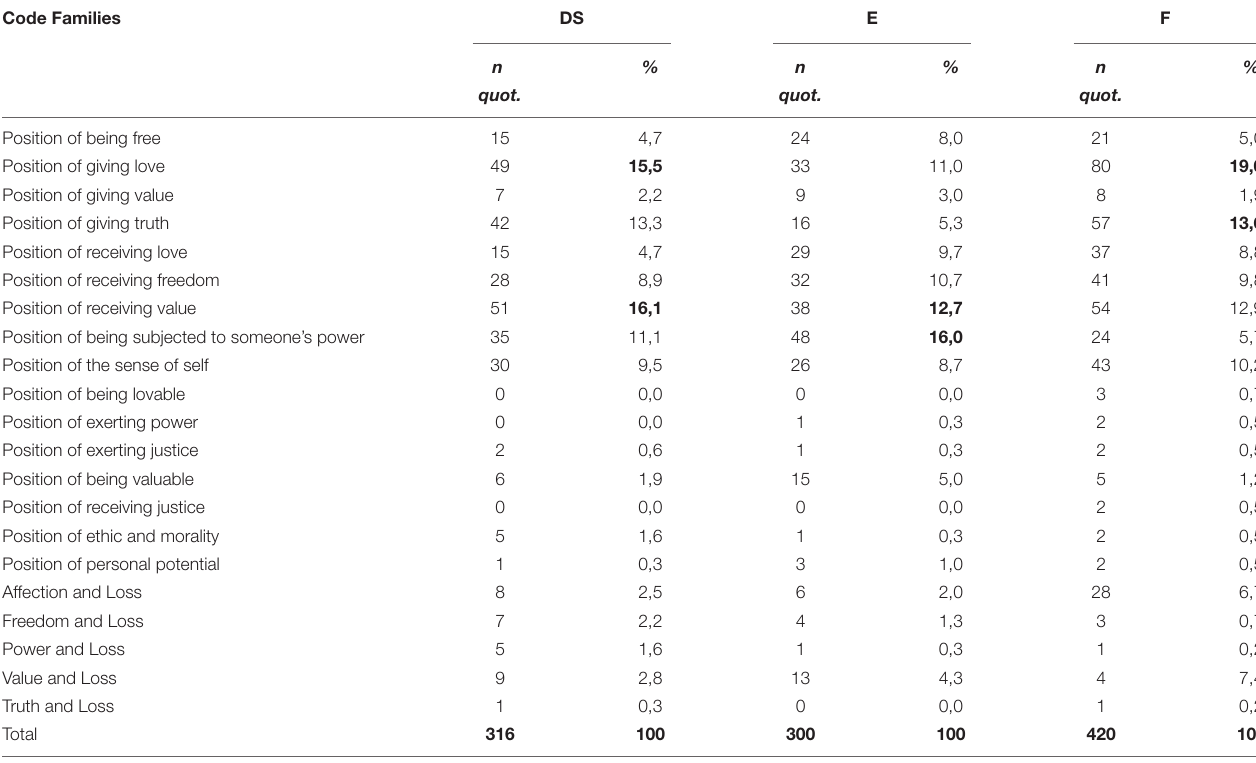
TABLE 7 | Frequency distribution of indirect indicators in the AAI Groups. Code Families